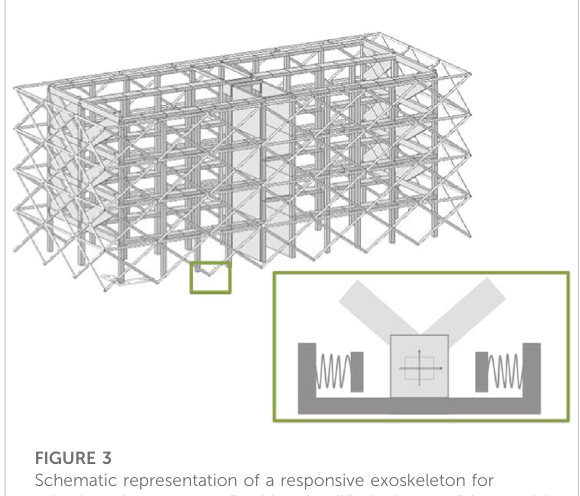
FIGURE 3 Schematic representation of a responsive exoskeleton for seismic and energy retro fi t with a simpli fi ed scheme of the special sliding supports (adapted from (Labò et al., 2016))